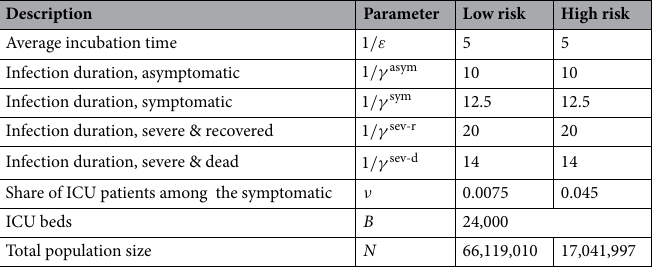
Table 3. Parameter values.